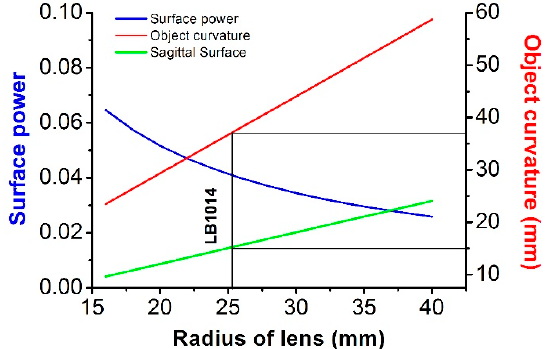
Figure 6. Change in surface power and object curvature with change in curvature radius of lens. These radii of the lens consider both sides of biconvex lens, and have the same focal length as the radius.